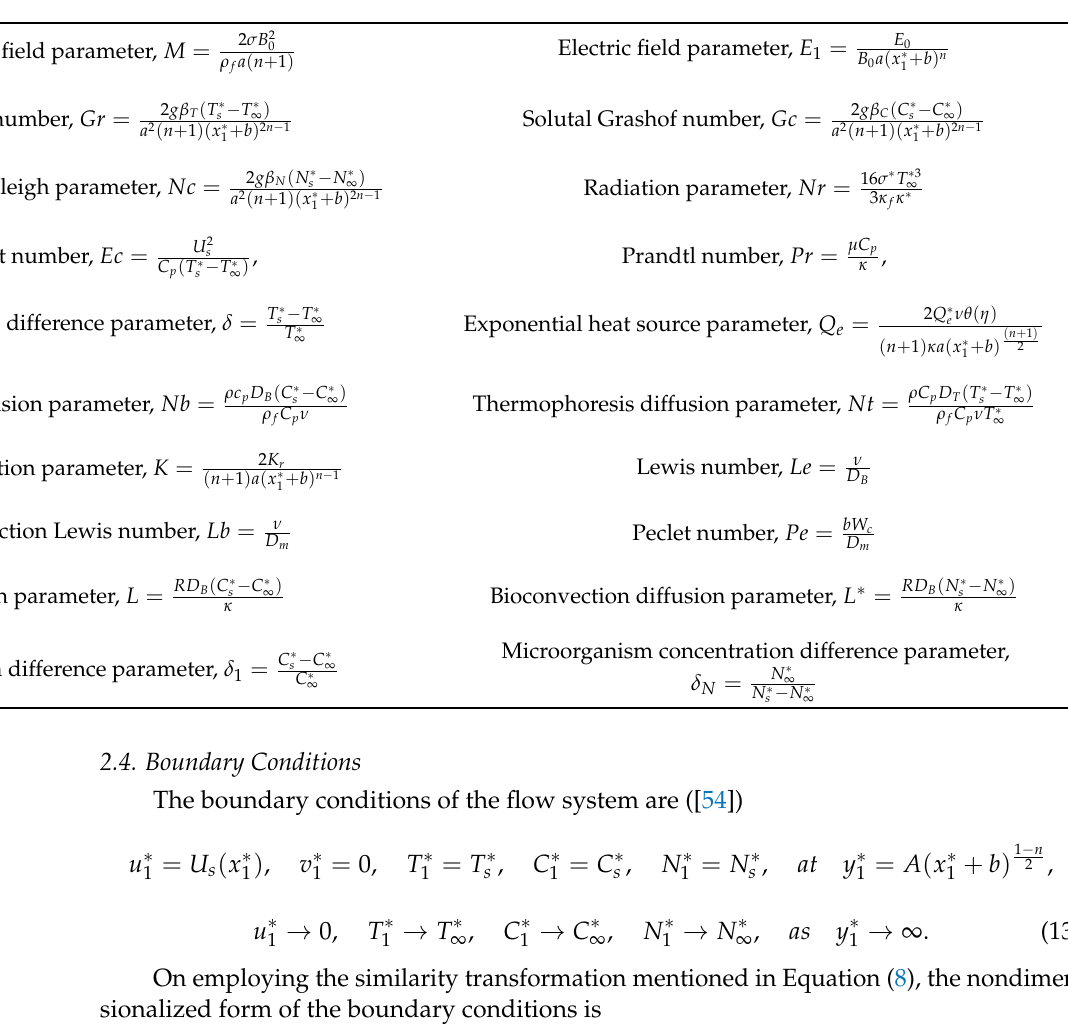
Table 1. Dimensionless parameter of the fluid model